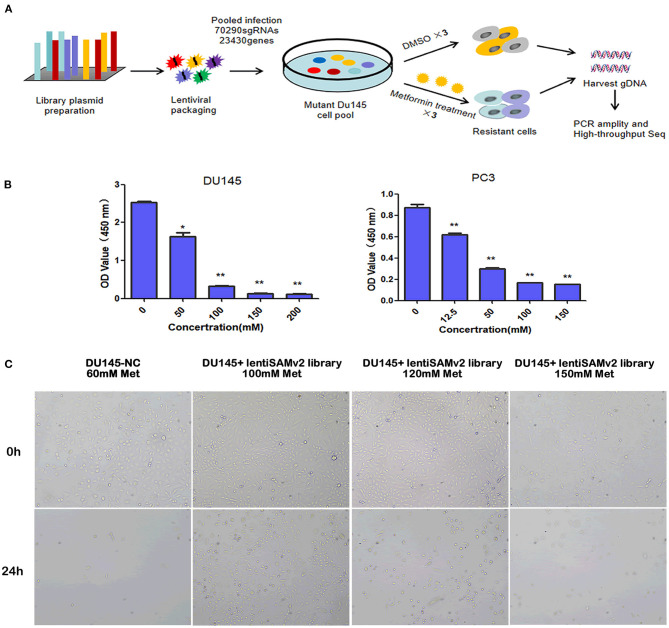
Schematic of functional screening by the CRISPR/Cas9 SAM pooled library and metformin treatment. (A) Schematic of metformin-resistant DU145 cells construction for high-throughput sequencing analysis; (B) PC3 (0, 12.5, 50, 100, 150 mM) and DU145 (0, 50, 100, 150, 200, 200 mM) cell lines were treated with the indicated doses of metformin for 24 h, and cell viability was measured using a CCK8 assay. Data were represented as mean ± SEM of a representative experiment (of three experiments); (C) optical microscopic images of DU145 cells transfected with lentiSAMv2 control or lentiSAMv2 pooled library and treated with metformin (60, 100, 120, 150 mM).